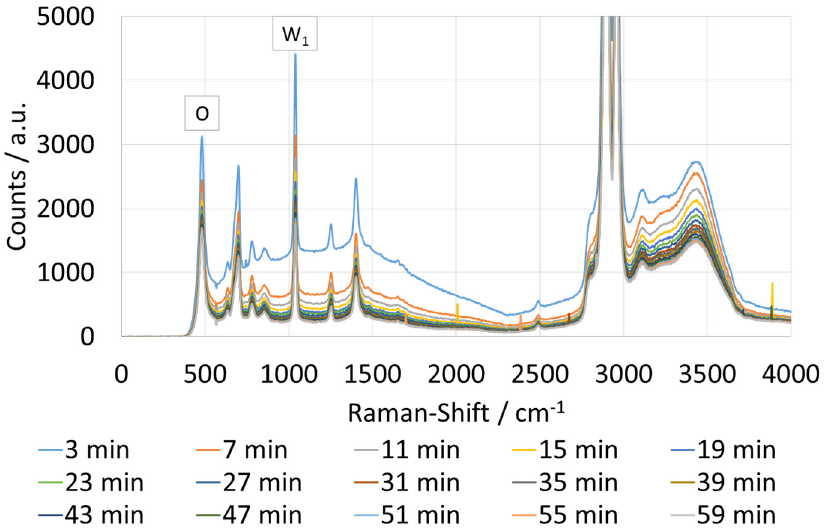
Figure 4. Progress of the spectra of one measurement series. The inner water phase contained 49% ammonium nitrate, the concentration of ammonium chloride in the outer phase was 10%.